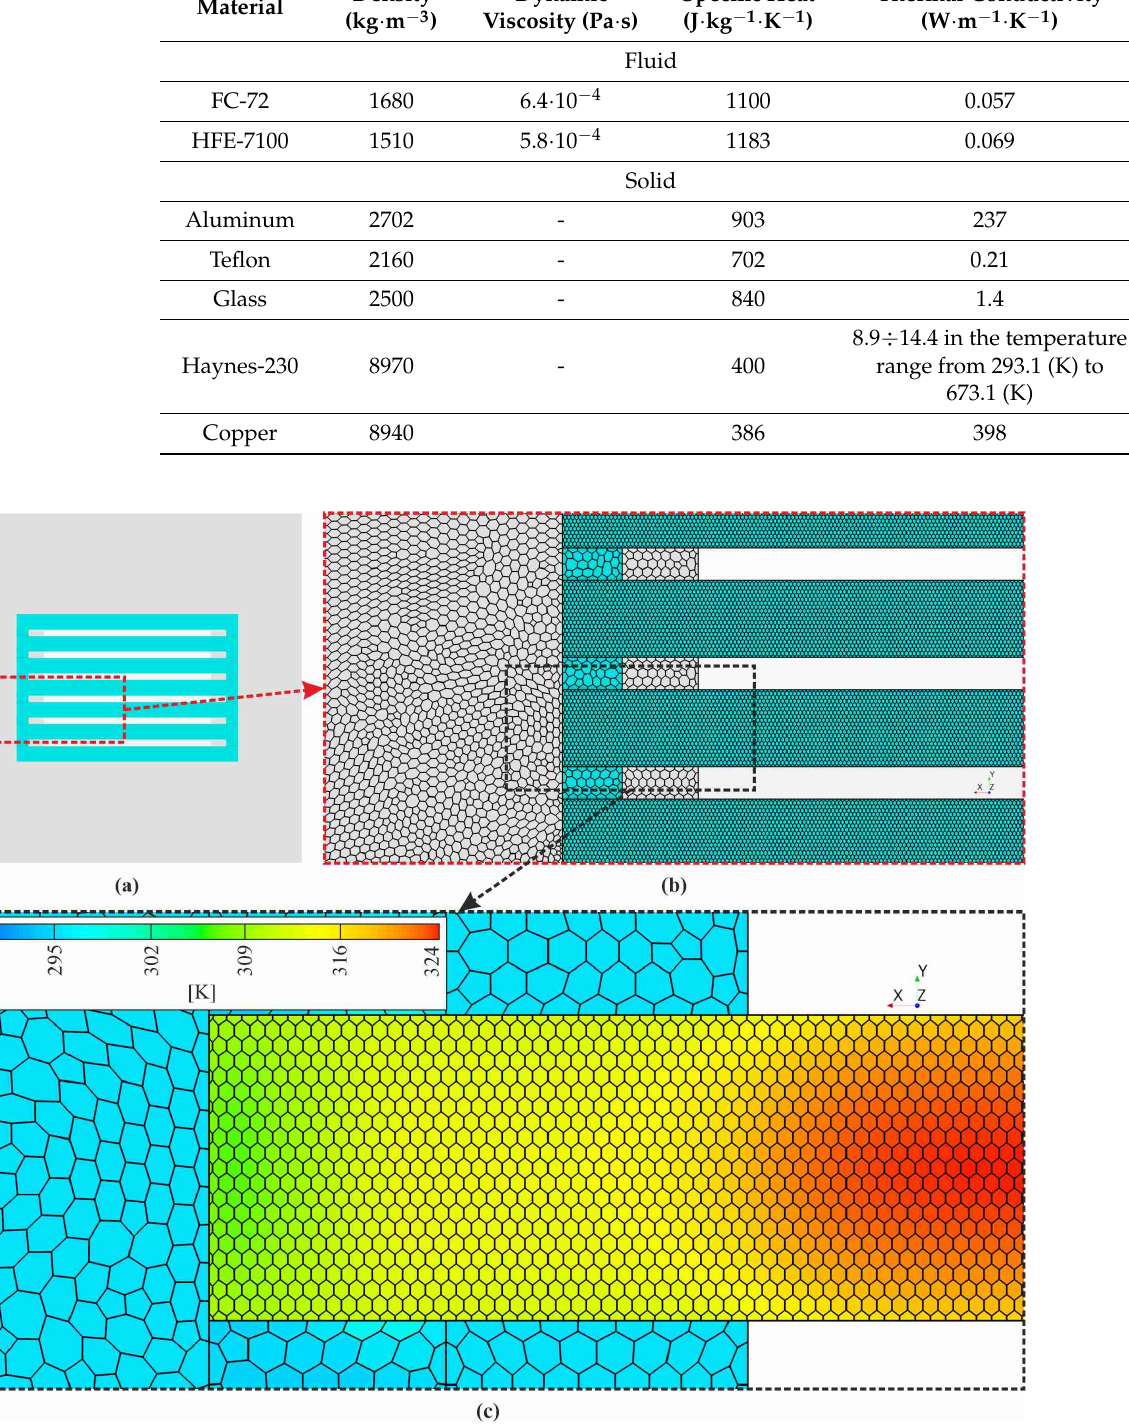
Figure 5. ( a , b ) Two-dimensional view of the channel body and the working fluid in the test section (solid and fluid regions): general ( a ) and detailed, showing polyhedral mesh ( b ), fluid region marked in cyan and solid region marked in gray colors; ( c ) temperature distribution on marked elements.